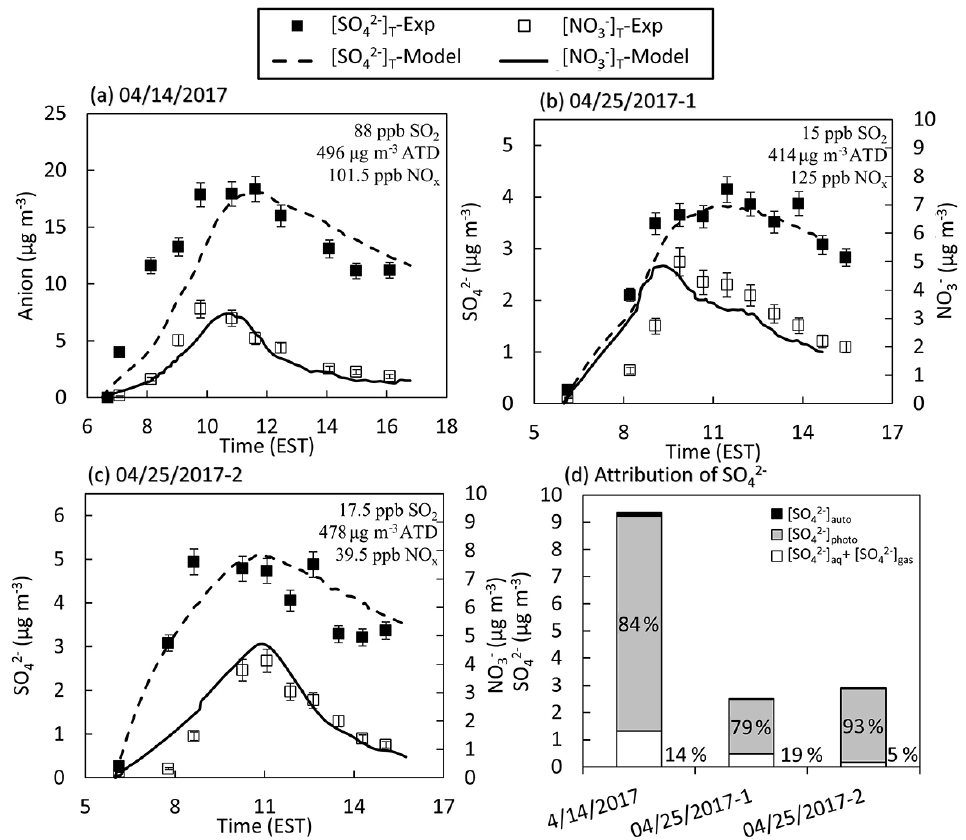
Figure 4. Time profiles of total sulfate concentration ([SO 2 − ] T ,µgm − 3 ) and nitrate concentration ([NO − ] T ,µgm − 3 ) in the dual-chamber 4 3 experiments using UF-APHOR at different NO x levels. The concentrations of sulfate and nitrate were measured using PILS-IC during the experiments. The error bars of the concentration of sulfate and nitrate is ± 10% originated from the PILS-IC measurement. The detailed experimental conditions of (a) , (b) , and (c) are shown in Table 2. Panel (d) shows how total sulfate is attributed to aqueous-phase reaction (sulfate formation in gas phase + sulfate formation in inorganic salted inorganic aqueous phase) ([SO 2 − ] aq + [SO 2 − ] gas ) , dust-phase autoxi- 4 4 dation ([SO 2 − ] auto ) , and dust photochemistry ([SO 2 − ] photo ) at the end of the experiments. “Exp” denotes the experimental observation and 4 4 “Model” denotes the simulation using the AMAR module. The chamber dilution and the wall process of gaseous compounds and particles were included in the simulation (Sect.